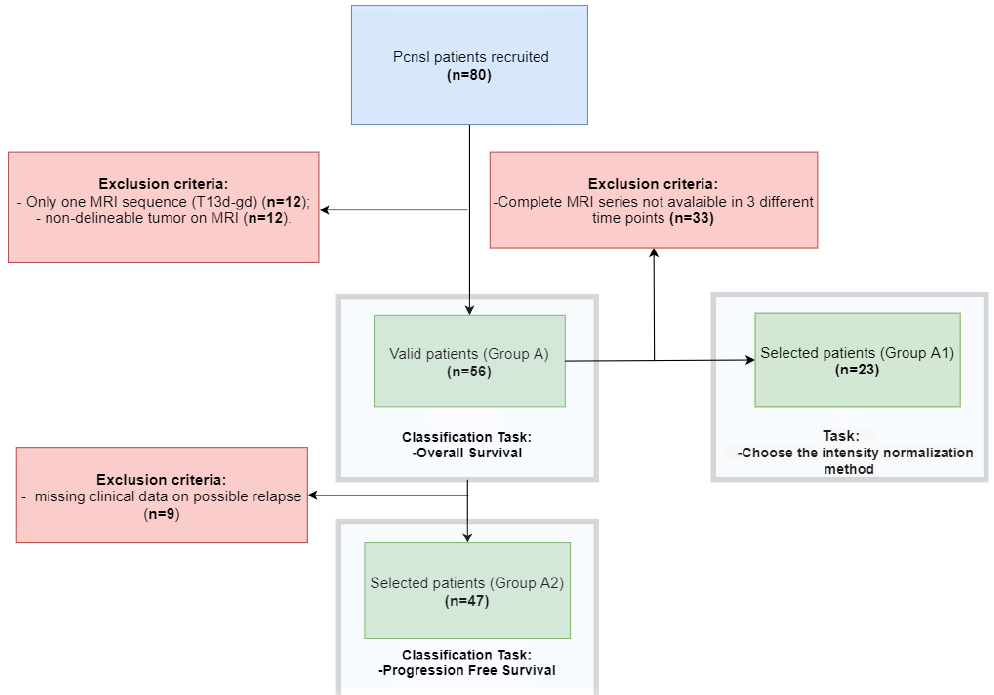
Figure 1. Flowchart of the patient enrolment process. In the blue box, the initial number of patients available for this study. In the red box, the reasons for exclusion of some patients (unavailability of complete MRI sequences or missing clinical data). In the green box, the number of patients selected for the specific